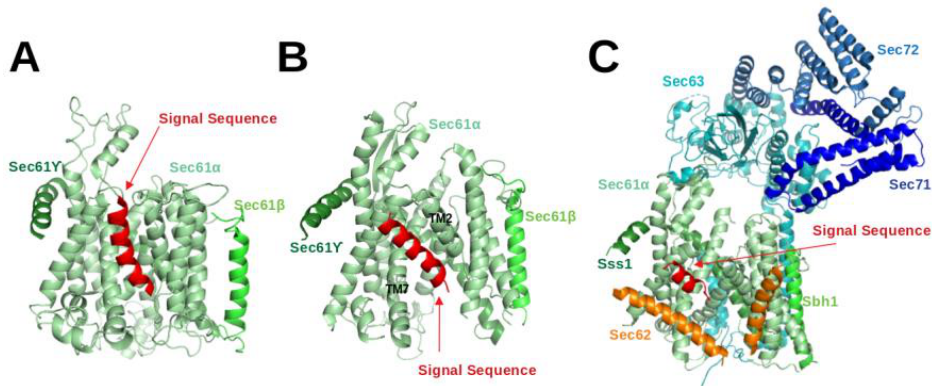
1 Figure 3. Shown are cryo-EM structures of the signal sequence-bound Sec61 complex ( A ) in the co-translational mode (4CG6; Canis lupus ) [28], ( B ) in the co-translational mode (3JC2; Canis lupus ) [4] and ( C ) in the post-translational mode (7AFT; Saccharomyces cerevisiae )